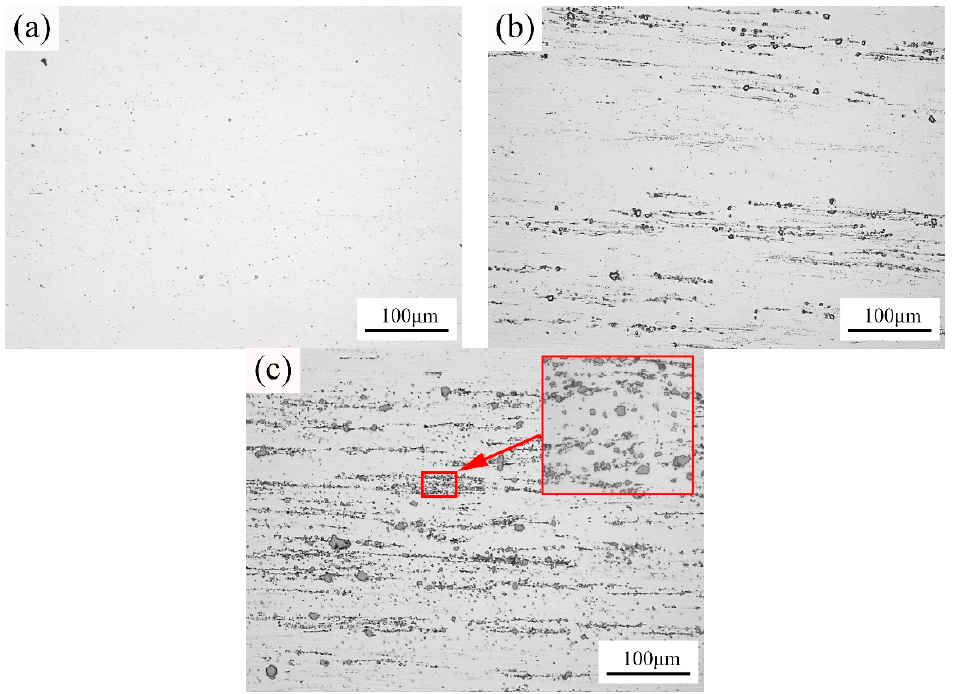
Figure 3. Optical microscopy micrographs of the Al-5Mg filler wires containing: ( a ) 0 wt% TiC particles; ( b ) 2 wt% TiC particles; ( c ) 4 wt% TiC